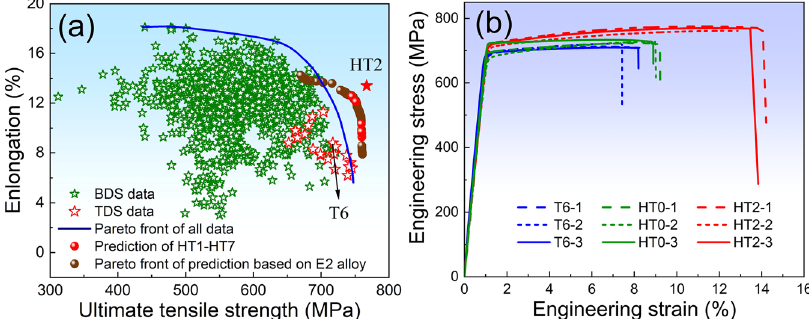
Fig. 3 Multi-objective optimization results and comparison of alloy performance. a The data distribution of BDS and TDS data sets and the Pareto front formed by them, and the Pareto front of E2 alloy properties determined by NSGA - II algorithm (the red dots are the prediction results of HT1-HT7). The red pentagram corresponds to the experimental results of HT2 in Table 1; b The engineering stress-strain curves of E2 specimens treated by T6, HT0, and HT2 processes are in Table